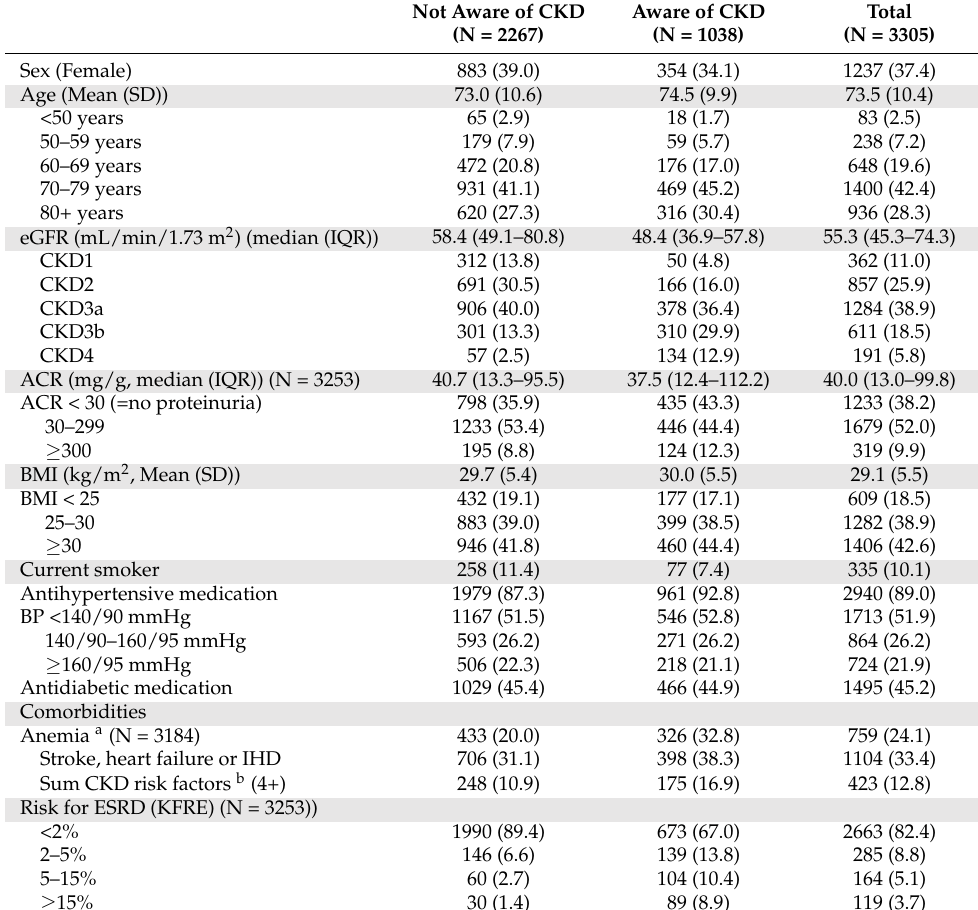
Table 1. Characteristics of all participants and stratified by awareness for chronic kidney disease (CKD): prevalence (N, %), mean and standard deviation (SD) or median and interquartile ranges (IQR). German CKD related cohorts (CORE database), 2010. Not Aware of CKD Aware of CKD (N = 2267) (N = 1038)